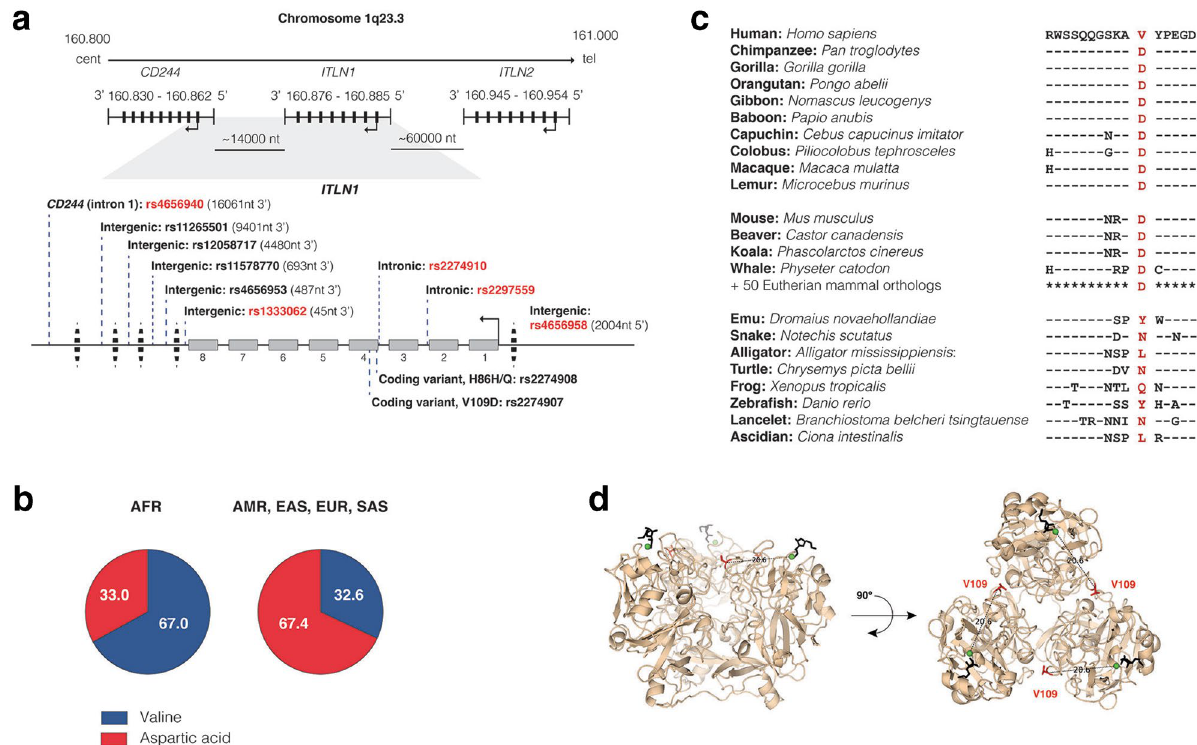
Figure 1. ITLN1 polymorphisms. ( a ) The physical arrangement of ITLN1 relative to centromere/ telomere orientation and flanking genes on chromosome 1q23.3 is diagramed, along with single nucleotide polymorphisms associated with human disease, including IBD: rs4656940 23 , rs11265501 58 , rs12058717 59 , rs11578770 60 , rs4656953 61 , rs1333062 24 , rs2274907 30 , rs2274908 30 , rs2274910 1 , rs2297559 25 , and rs4656958 25–27 . Red text highlights GWAS-identified SNPs. ( b ) 1000 Genomes Project Phase 3 super population allele frequency (percentages) of rs2274907 (A/T, V109D): AFR, African; AMR, American, EAS, East Asian; EUR, European; SAS, South Asian 31,32 . ( c ) 3D structure of human trimeric ITLN1 bound to β-D-galactofuranose (black). The distance between V109 residue (red) and coordinating calcium (green) are indicated on each monomer (PDB: 4WMY). ( d ) Amino acid sequence adjacent to coding variant rs2274907 (V109D) in orthologs of human ITLN1 (“—” identical residue present